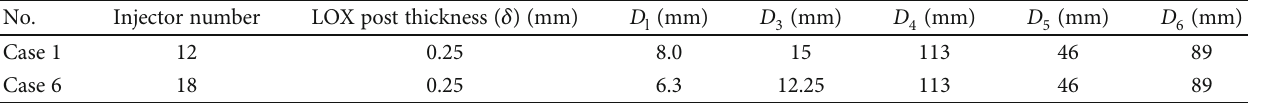
Table 2: Parameters of injector